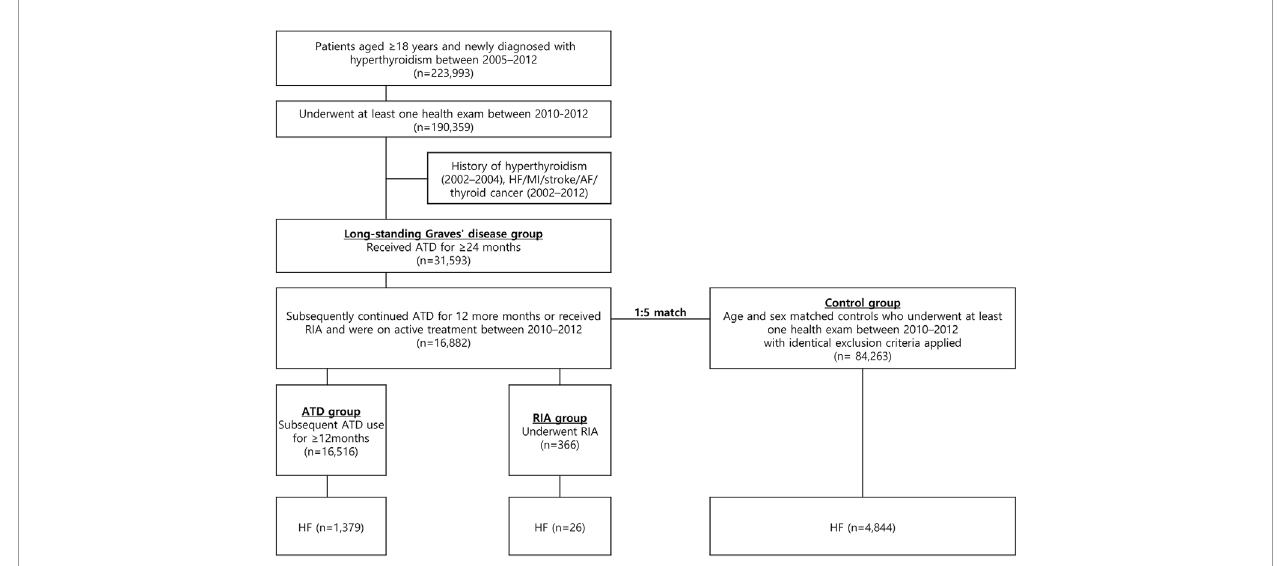
FIGURE 1 | Flowchart of the study. ATD, anti-thyroid drug; AF, atrial fi brillation; HF, heart failure; MI, myocardial infarction; RIA, radioactive iodine